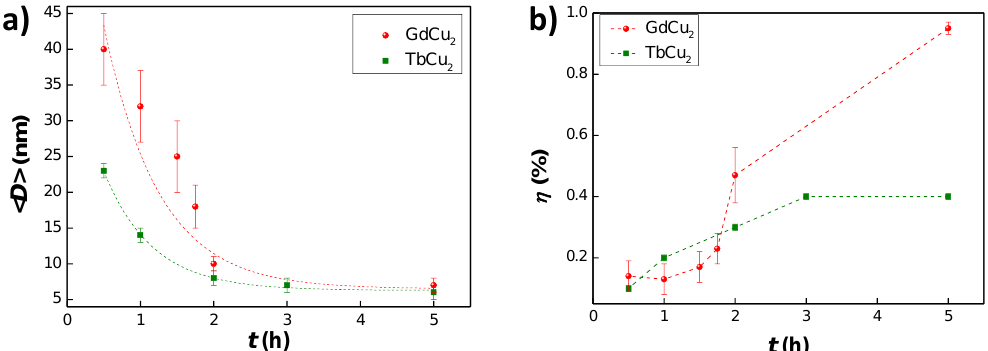
Figure 2. Evolution of the ( a ) mean diameter size (cid:104) D (cid:105) and ( b ) microstrain η of GdCu 2 NPs (red spheres) and TbCu 2 (green squares) (data for the latter taken from [20]) with milling time t . Dashed lines are sketched as a guide for the